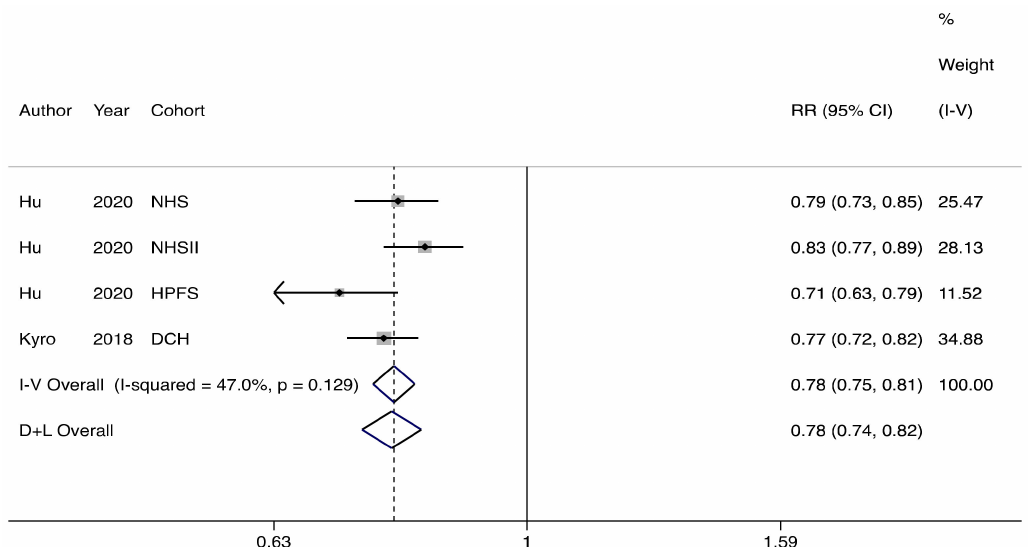
Figure 2. The association between oat consumption and risk of type 2 diabetes. Participants with highest vs. lowest oat consumption are compared. I-V: inverse-variance estimation, random effect model. D + L: DerSimonian–Laird (DL) method, fixed effect model